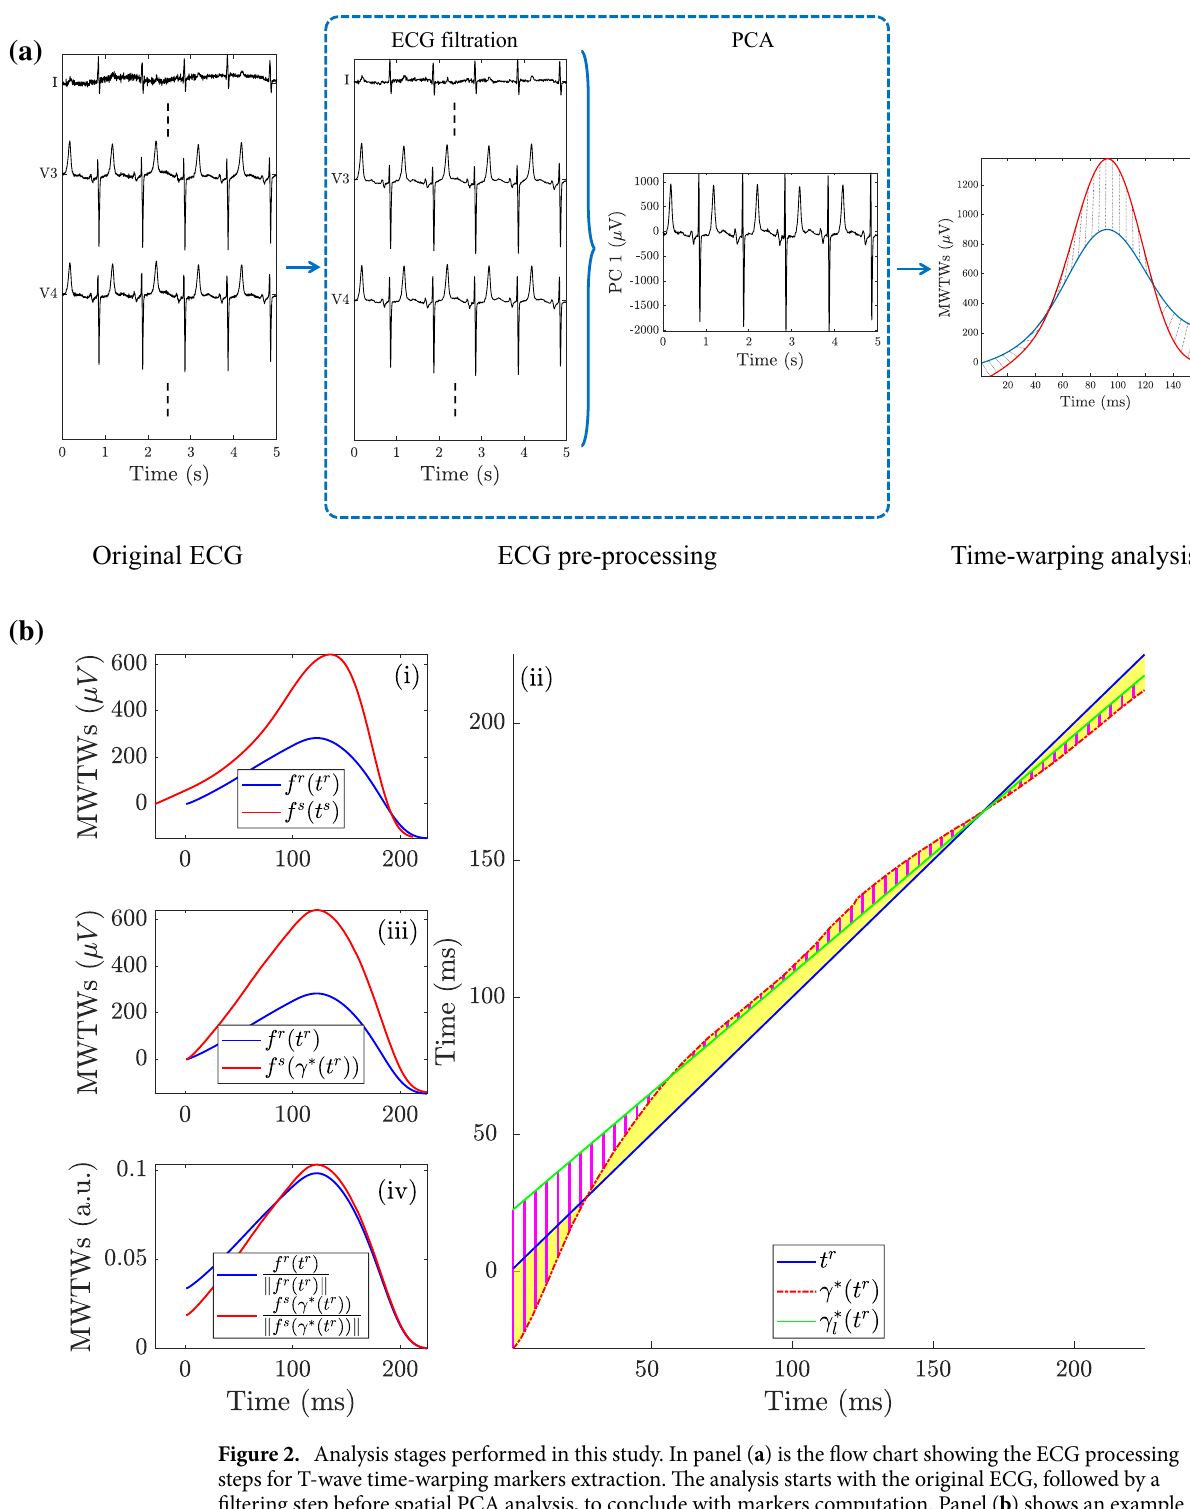
Figure 2. Analysis stages performed in this study. In panel ( a ) is the flow chart showing the ECG processing steps for T-wave time-warping markers extraction. The analysis starts with the original ECG, followed by a filtering step before spatial PCA analysis, to conclude with markers computation. Panel ( b ) shows an example of the linear and nonlinear time-warping markers for the same patient as in Fig. 5a. In particular, subpanel (i) shows both the reference (blue) and the i -th MWTW (red) while subpanel (ii) shows the warping function (red dotted line) that optimally relates the reference and studied MWTWs. Subpanel (iii) shows the MWTWs after warping and subpanel (iv) are the normalized reference and warped